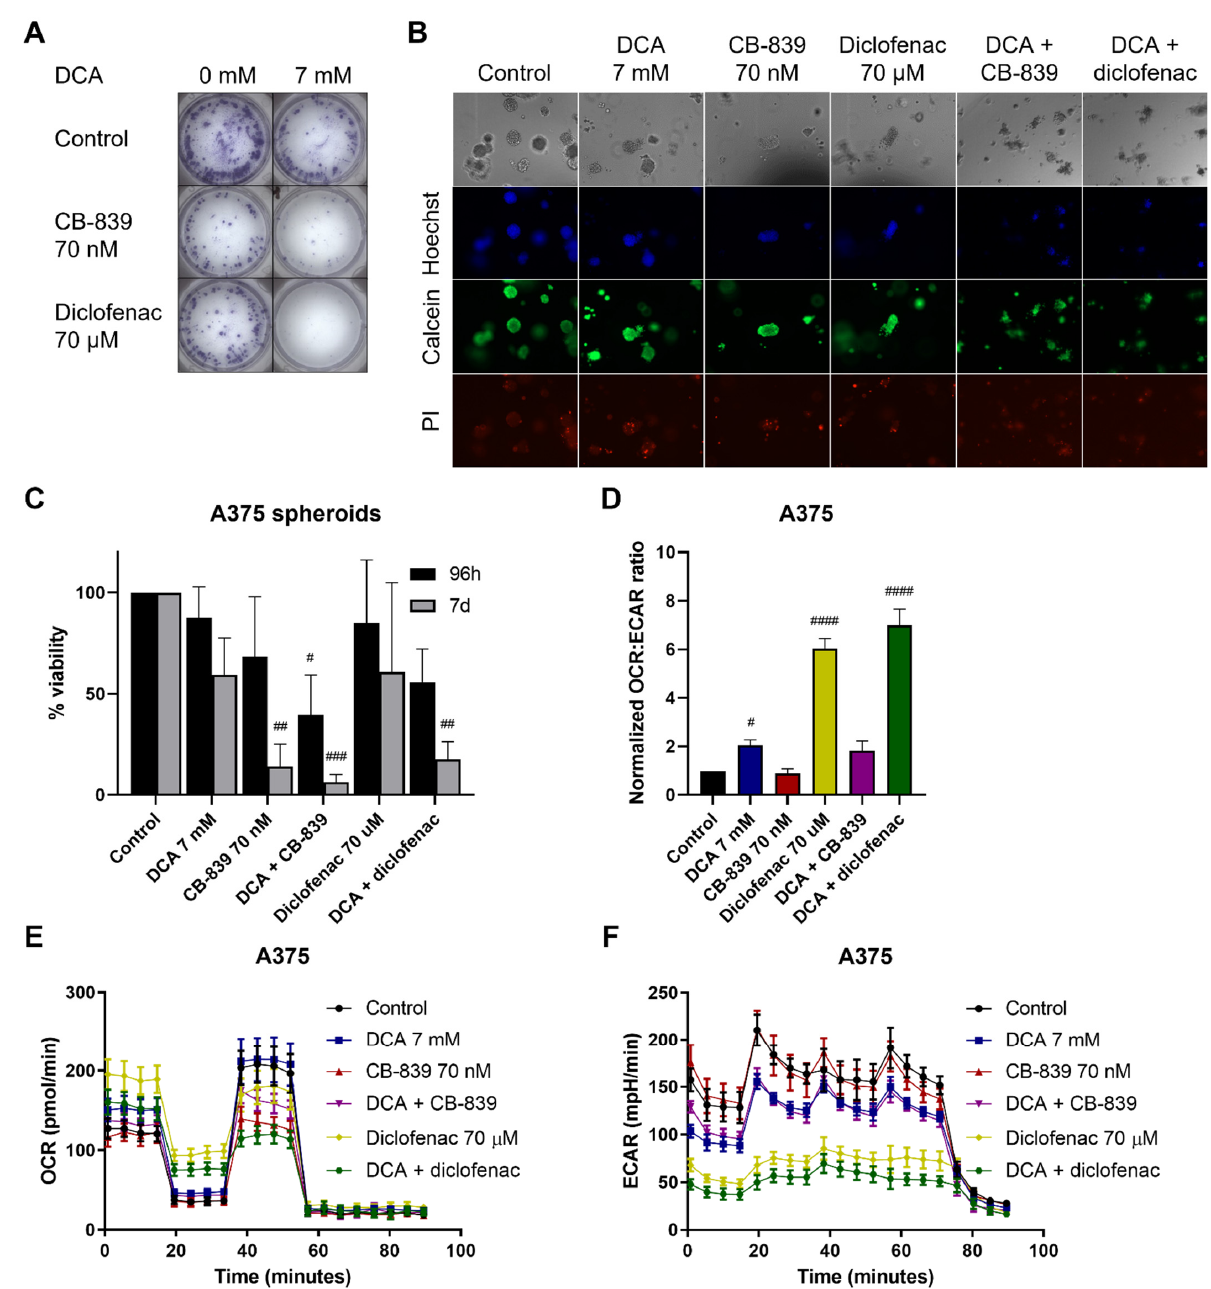
Figure 6. Clonogenicity and metabolic phenotype of A375 cells under DCA treatment combined with CB ‐ 839 and diclofenac. ( A ) Representative image of clonogenic assay of A375 after 9 days of treatment with DCA and CB ‐ 839 or diclofenac. ( B ) Representative image of Hoechst/Calcein/PI staining of A375 spheroids treated with DCA and CB ‐ 839 for 96 h. 10× magnification. ( C ) Viability of A375 cells grown in Matrigel treated with DCA and CB ‐ 839 or diclofenac for either 96h after initial spheroid development or treated continuously for 7 days. ( D ) OCR:ECAR ratio (here, normalized to untreated cells) after DCA, CB ‐ 839, diclofenac and combination treatments. ( E ) Representative image of OCR in A375 cells measured by Seahorse, mean ± SD of 6–8 technical replicates are shown. ( F ) Representative image of ECAR in A375 cells measured by Seahorse, mean ± SD of 6–8 technical replicates are shown. ( C , D ) Data represent mean ± SD of 3 independent experiments, each performed in quadruplicate. One ‐ way ANOVA followed by Dunnett’s multiple comparison test, # p < 0.05, ## p < 0.01, ### p < 0.001, #### p < 0.0001, drug ‐ treated vs. control.